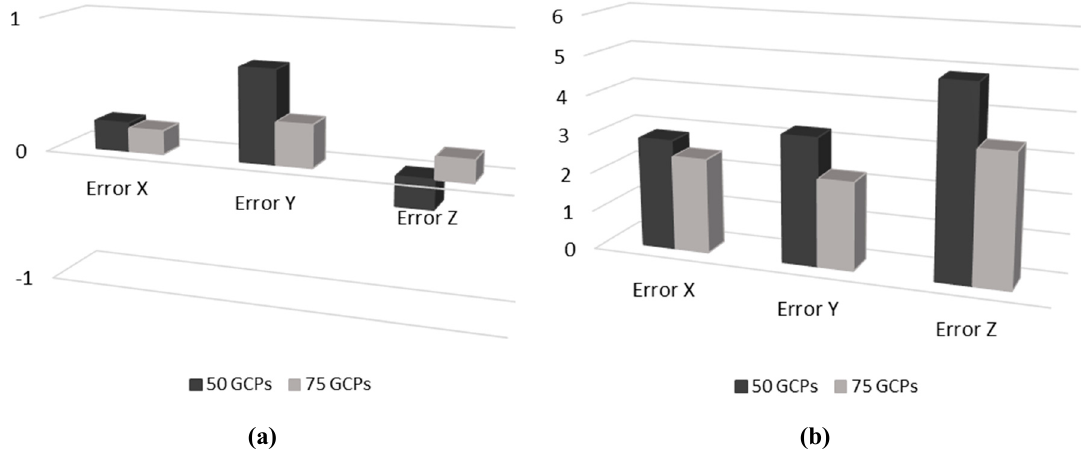
Figure 15. Variation of mean and standard deviation values after the two steps. ( a ) Mean values; ( b ) standard deviation values.